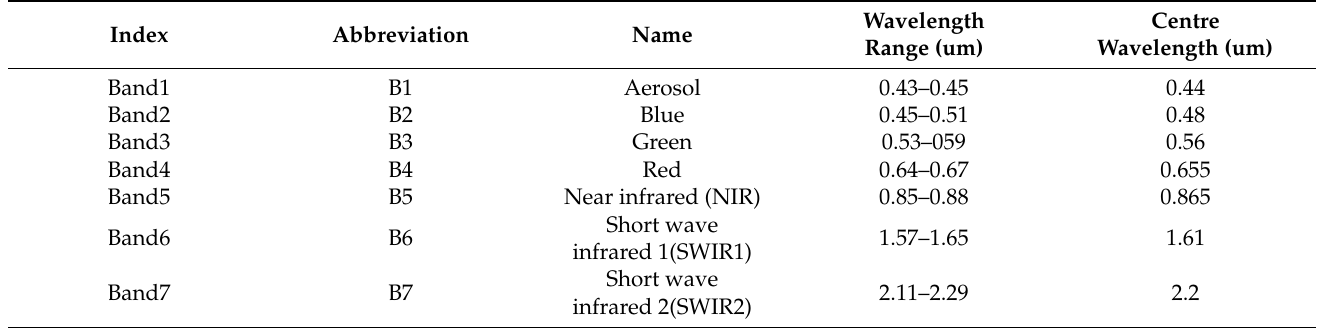
Table A1. Spectral reflectance factor.